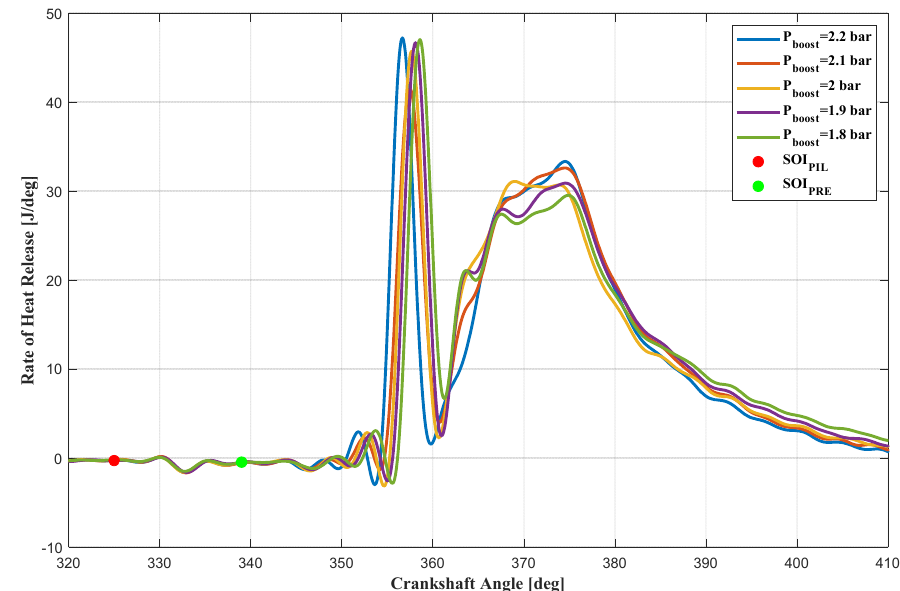
Figure 8. RoHR curves at different intake pressure.